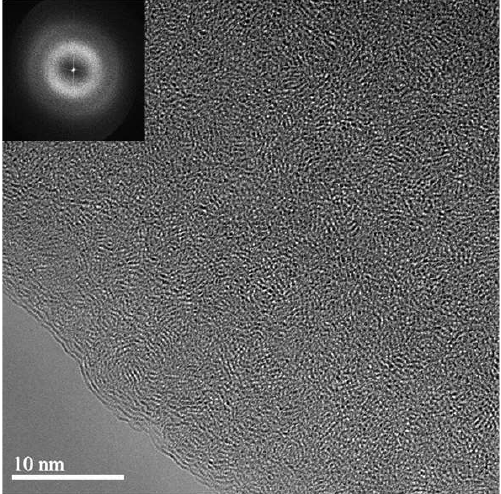
Figure 4. High-resolution TEM image of a 3D-printed carbon structure. The inset shows the corre- sponding Fast Fourier Transform (FFT) image.